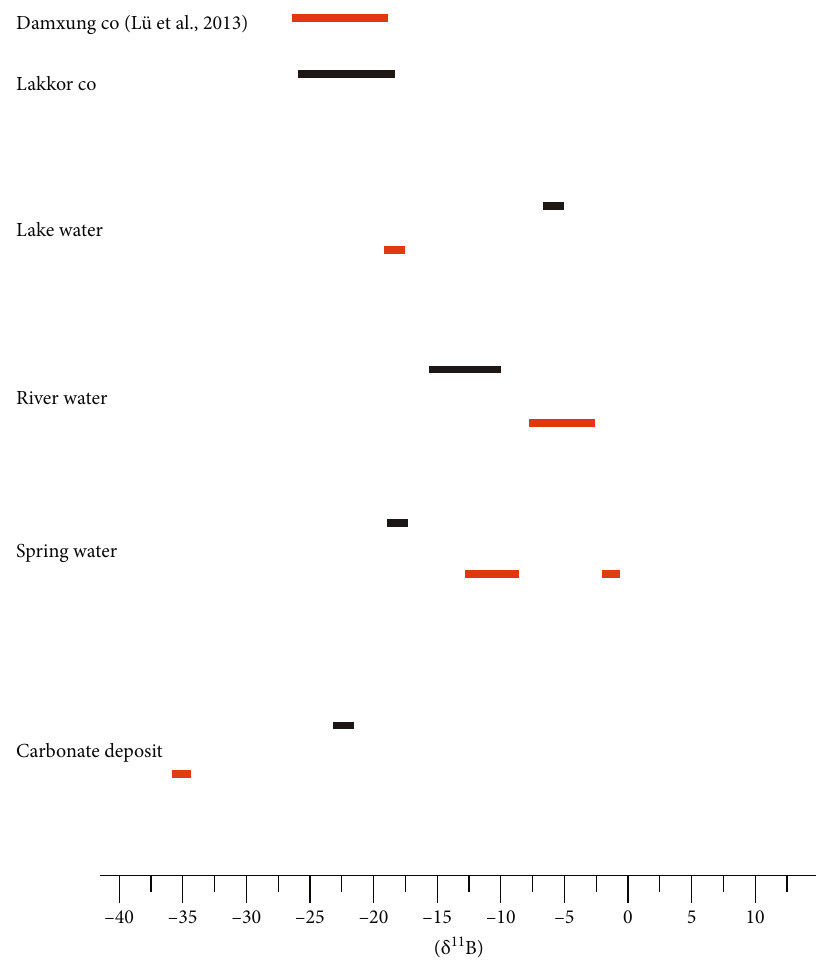
Figure 9: Comparison of boron isotopes between Lakkor Co and Damxung Co (boron isotope data of Damxung Co are taken from Lü et al.